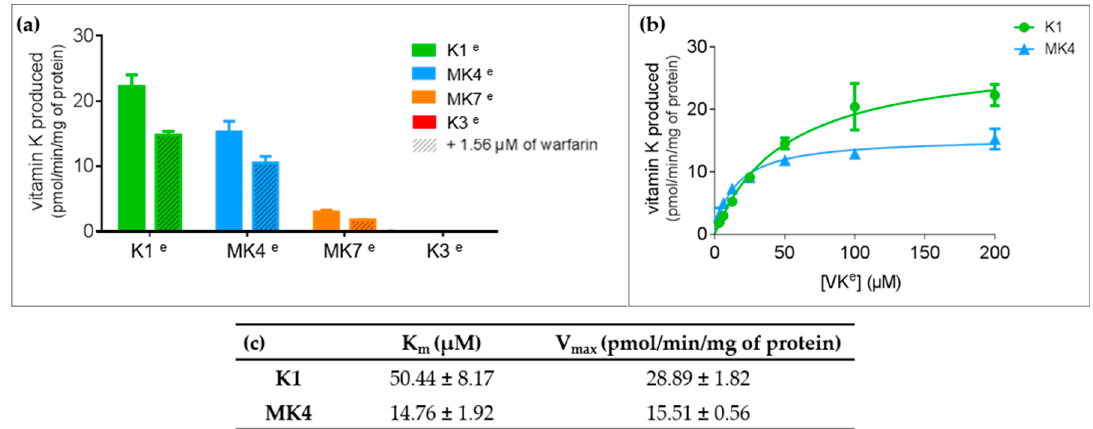
Figure 8. Vitamin K epoxide reductase (VKOR) activity assays and kinetics. ( a ) Specific vitamin K epoxide reductase activity towards vitamins K1 E , MK4 E , MK7 E , or K3 E . VKOR activity was evaluated in the presence of 100 µM of vitamins K E in the presence of 0 or 1.56 µM warfarin. ( b ) VKOR activity versus vitamins K1 E or MK4 E incubated with microsomal proteins expressing membrane wild-type human VKORC1. Each data point represents the mean ± standard deviation of three determinations in duplicates. Experimental results were fitted by nonlinear regression using the noncompetitive inhibition model. ( c ) Apparent kinetic parameters towards vitamins K1 E or MK4 E . To determine the VKOR activity, standard reactions were performed in 200 mM 4-(2-hydroxyethyl)-1-piperazineethanesulfonic acid (HEPES) buffer, pH 7.4, containing 150 mM KCl and 1.5 g · L − 1 microsomal proteins expressing membrane wild-type VKORC1. Each data point represents the mean ± standard deviation of three individual determinations in duplicates.